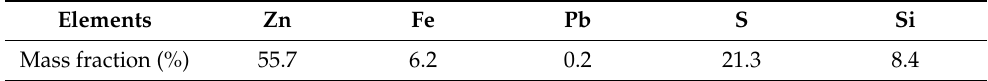
Table 1. Chemical composition of a mineral specimen of ZnS based on